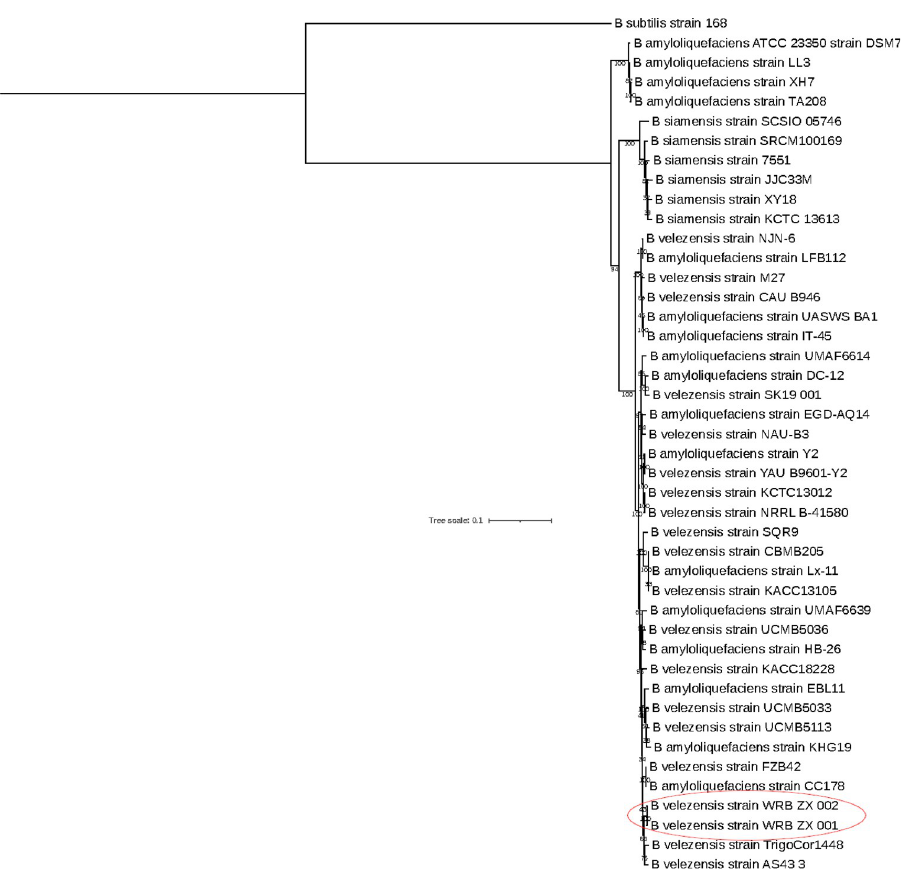
Fig 4. Core genome phylogeny of 43 Bacillus amyloliquefaciens group isolates. Maximum likelihood tree was constructed with core genome SNPs identified by kSNP. 41 reference genomes of Bacillus amyloliquefaciens group isolates were obtained from NCBI genome database. The core genome of Bacillus subtilis 168 was used as outgroup. Phylogeny was inferred by RAxML under time-reversible model with gamma distributed substitution sites and 1000 bootstrap repetitions. Bar represents 0.2 substitution per site. Isolates from this study were labeled with red circle.